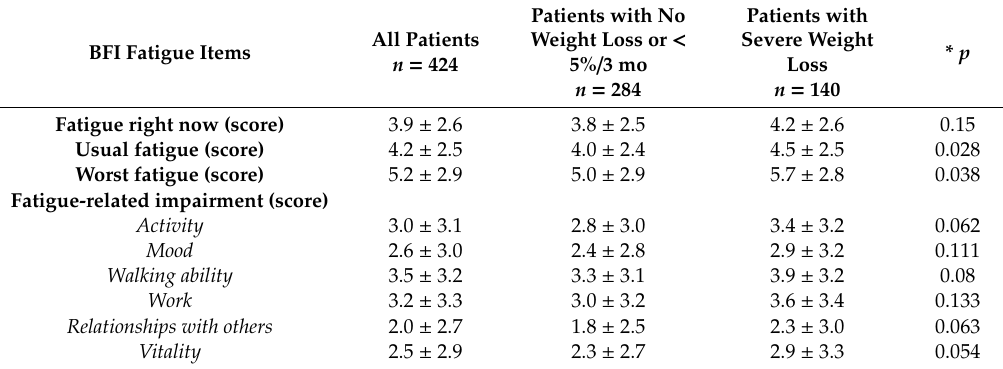
Table 2. Fatigue in all recruited patients and stratified according to self-reported severe weight loss.